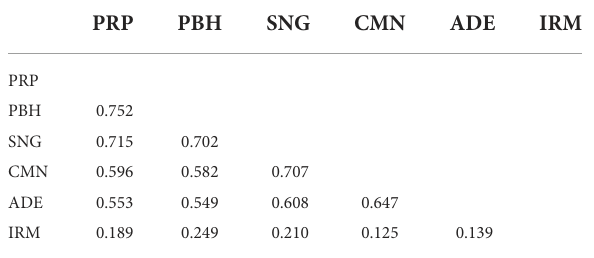
TABLE 4 Heterotrait–Monotrait ratio scale.